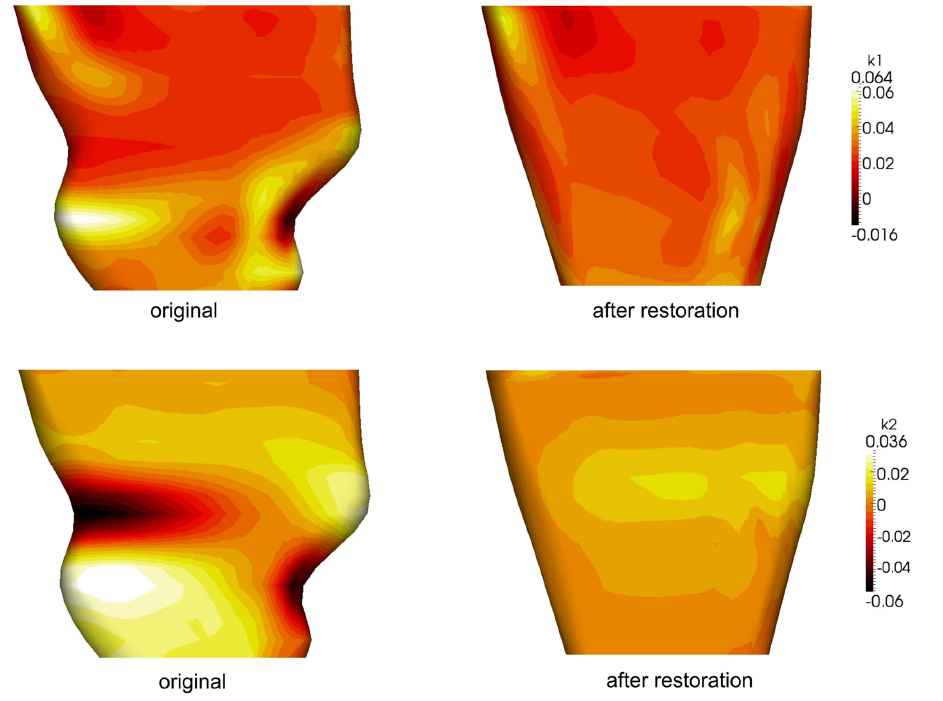
Figure 6. Changes in k 1 and k 2 before and after dual and free form geometric restoration. One sample of patient-specific 3D LV mesh model with its k 1 and k 2 values before and after dual and free form geometric deformation.